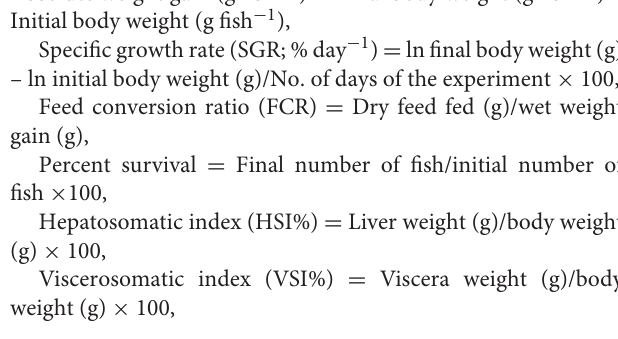
Fish oil replacement level